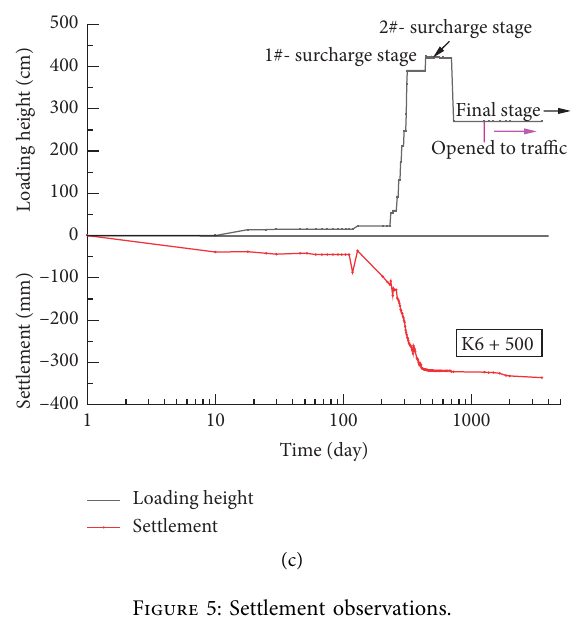
Figure 5: Settlement observations.